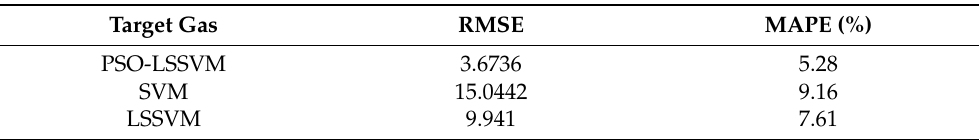
Table 11. Overall prediction effect of the PSO-LSSVM model on turbulent gas mixtures. Table 12. Concentration prediction results of ethylene gas in mixed gas using different concentration prediction